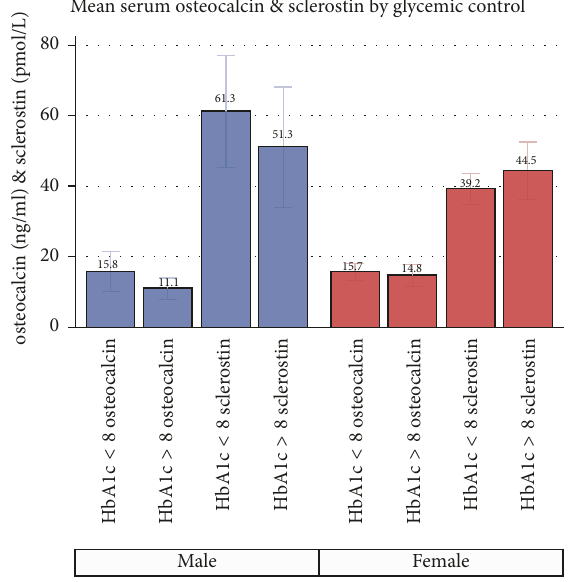
Figure 1: Mean distribution of serum osteocalcin and sclerostin in Mexican American men and women diagnosed with T2D, by levels of glycemic